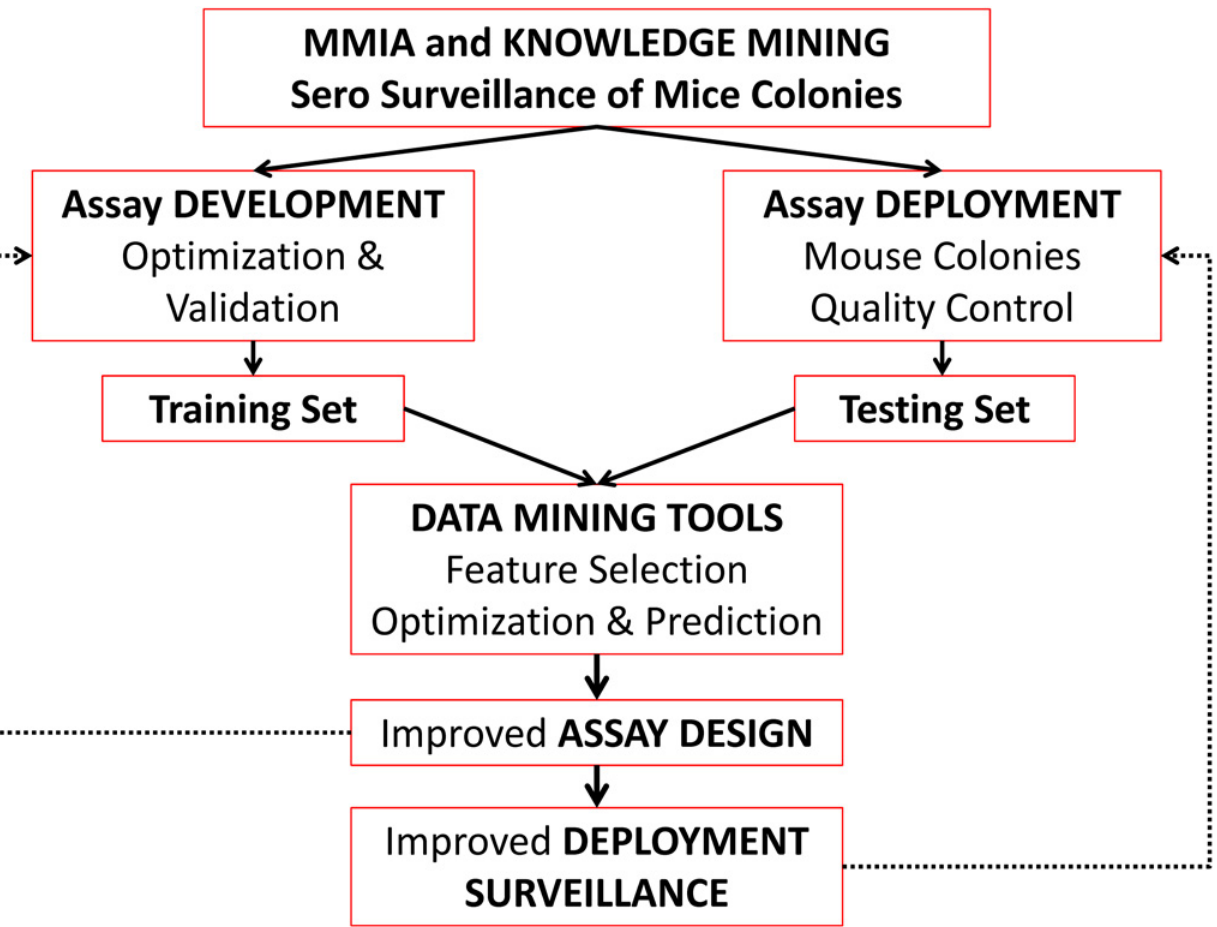
Figure 1. Flow chart of the data mining approach sero-surveillance of mice colonies. Multiplex microbead immunoassays (MMIA) results developed to detect multiple viruses are optimized and validated to develop the training set. Assays deployed in mice colonies were then used as the test set using a variety of data mining algorithms. This process leads to a better detection, optimization, and deployment of sero-detection of infectious diseases in mouse colonies. The proposed approach can be dynamically implemented for any large scale diagnostics for clinical and translational research